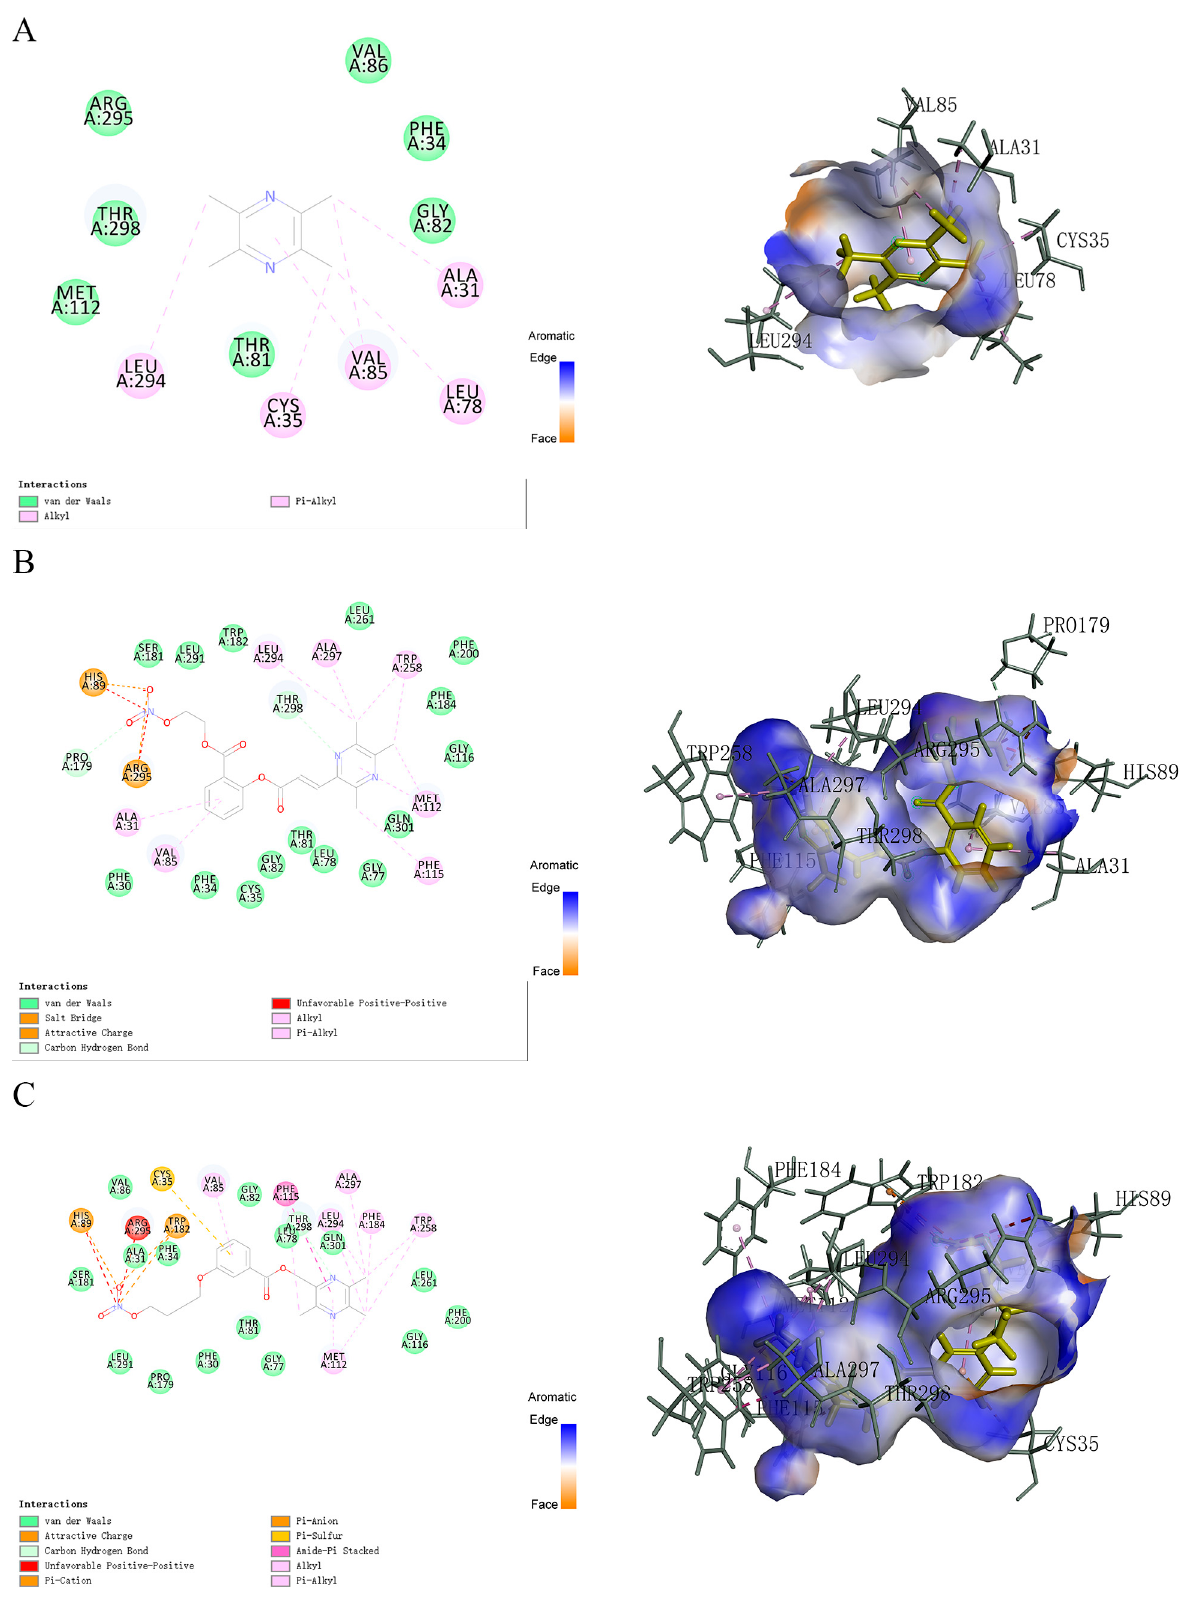
Figure 2. ( A ) TMP, ( B ) 14a and ( C ) 15d and interactions with TBXA2R (PDB 6IIV). Based on the above results, we speculated that the mode of action of the compounds might be to inhibit AA-induced platelet aggregation by acting on the active site of